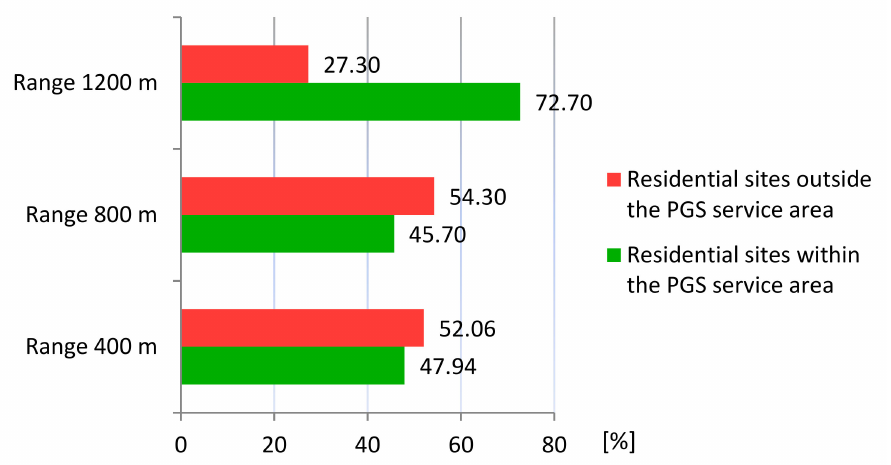
Figure 14. Residential sites in the PGS service areas and outside them according to land use